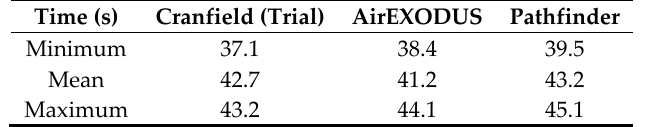
Table 1. Evacuation time comparison of trial by Cranfield, airEXODUS & Pathfinder in case study 1.